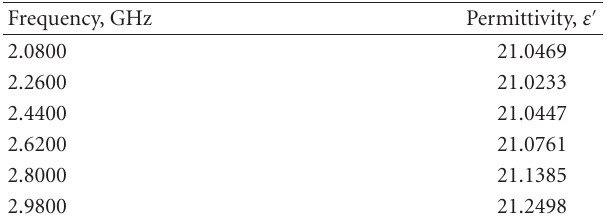
Table 1: Permittivity of BiT at frequency 2 to 3GHz. Frequency,